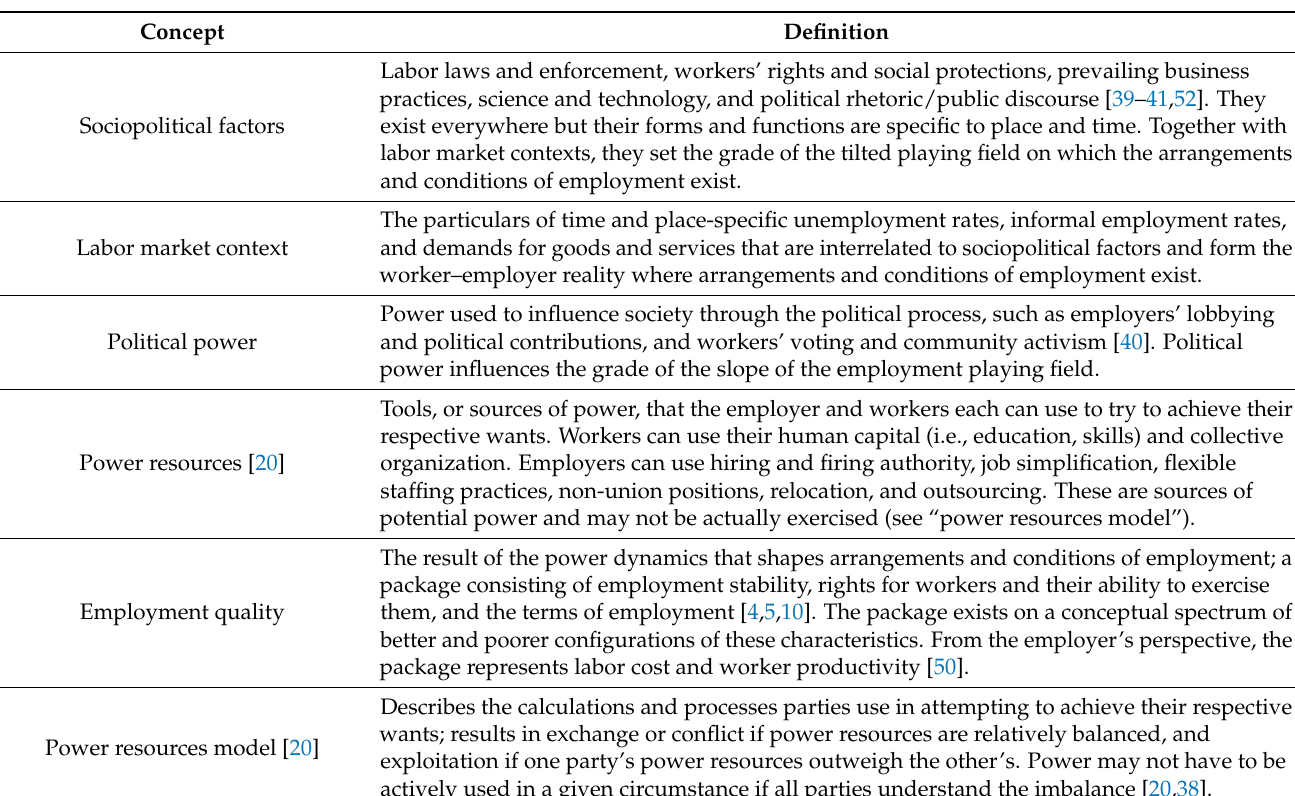
Table 1. Summary of concepts used in the allegory of employment quality